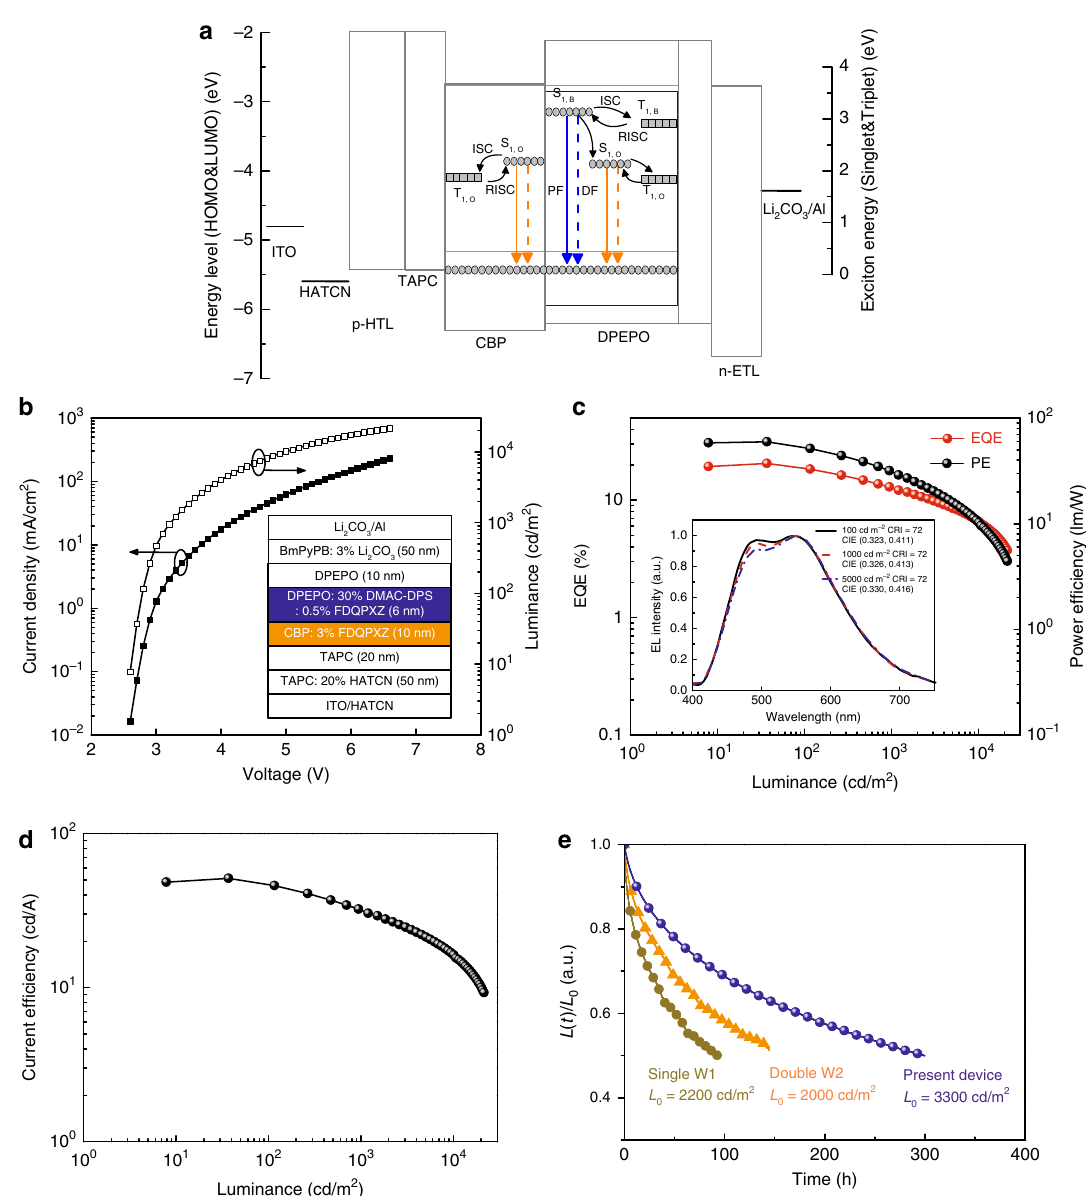
Fig. 2 Energy transfer processes and device performance. a Energy transfer processes in the emissive zones of the optimized fl uorescent white organic light-emitting diodes (WOLEDs). b Current density – voltage – luminance ( J – V – L ) characteristics of the fl uorescent WOLEDs. The inset illustrates the detailed device structure of the optimized WOLEDs. c External quantum ef fi ciency (EQE) and power ef fi ciency (PE)-luminance characteristics of the fl uorescent WOLED. Inset exhibits the normalized electroluminescence spectra at the different luminance of 100, 1000. and 5000 cd/m 2 , and the respective Commission Internationale de L ’ Eclairage (CIE) and color rendering index (CRI). d Current ef fi ciency-luminance characteristics of present WOLED. e Device lifetime measurement of conventional single- and double-emissive layer WOLEDs, and the present WOLED with proposed emissive